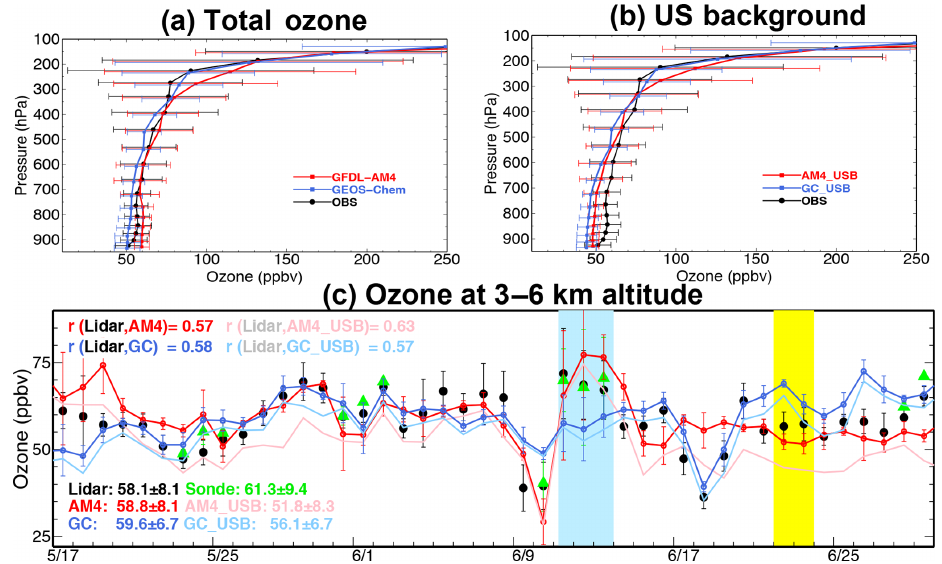
Figure 3. (a) Mean vertical O 3 profiles at Joe Neal as observed with ozonesondes (black; 30 launches) and simulated with GFDL-AM4 (red) and GEOS-Chem (blue) during FAST -LVOS (May–June 2017). Horizontal bars represent the standard deviations across daily profiles; (b) Same as (a) but showing US background (USB) O 3 estimated by the two models. (c) Time series of O 3 averaged over 3–6km altitude above NLVA during FAST-LVOS as observed (black: lidar; green: ozonesonde) and simulated with GFDL-AM4 (thick red line) and GEOS- Chem (thick dark blue line), together with simulated USB O 3 (light lines). Here and in other figures, AM4_USB represents USB estimated by GFDL-AM4 and GC_USB represents USB estimated by GEOS-Chem. The blue shading highlights the period with stratospheric intrusions and the yellow shading, the wildfire event. Vertical bars represent the standard deviations across hourly